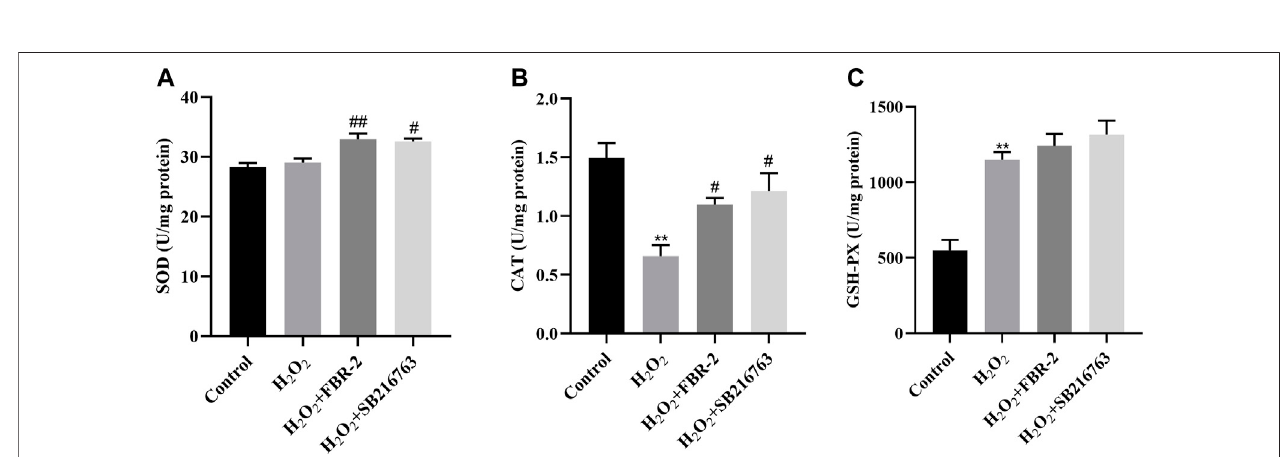
FIGURE 4 | FBR-2 protects cells by regulating enzyme activity. (A) Activity of SOD ( n = 6). (B) Activity of CAT ( n = 6). (C) Activity of GSH-PX ( n = 6). ** p < 0.01, compared with the control group; # p < 0.05 and ## p < 0.01, compared with the H 2 O 2 group.